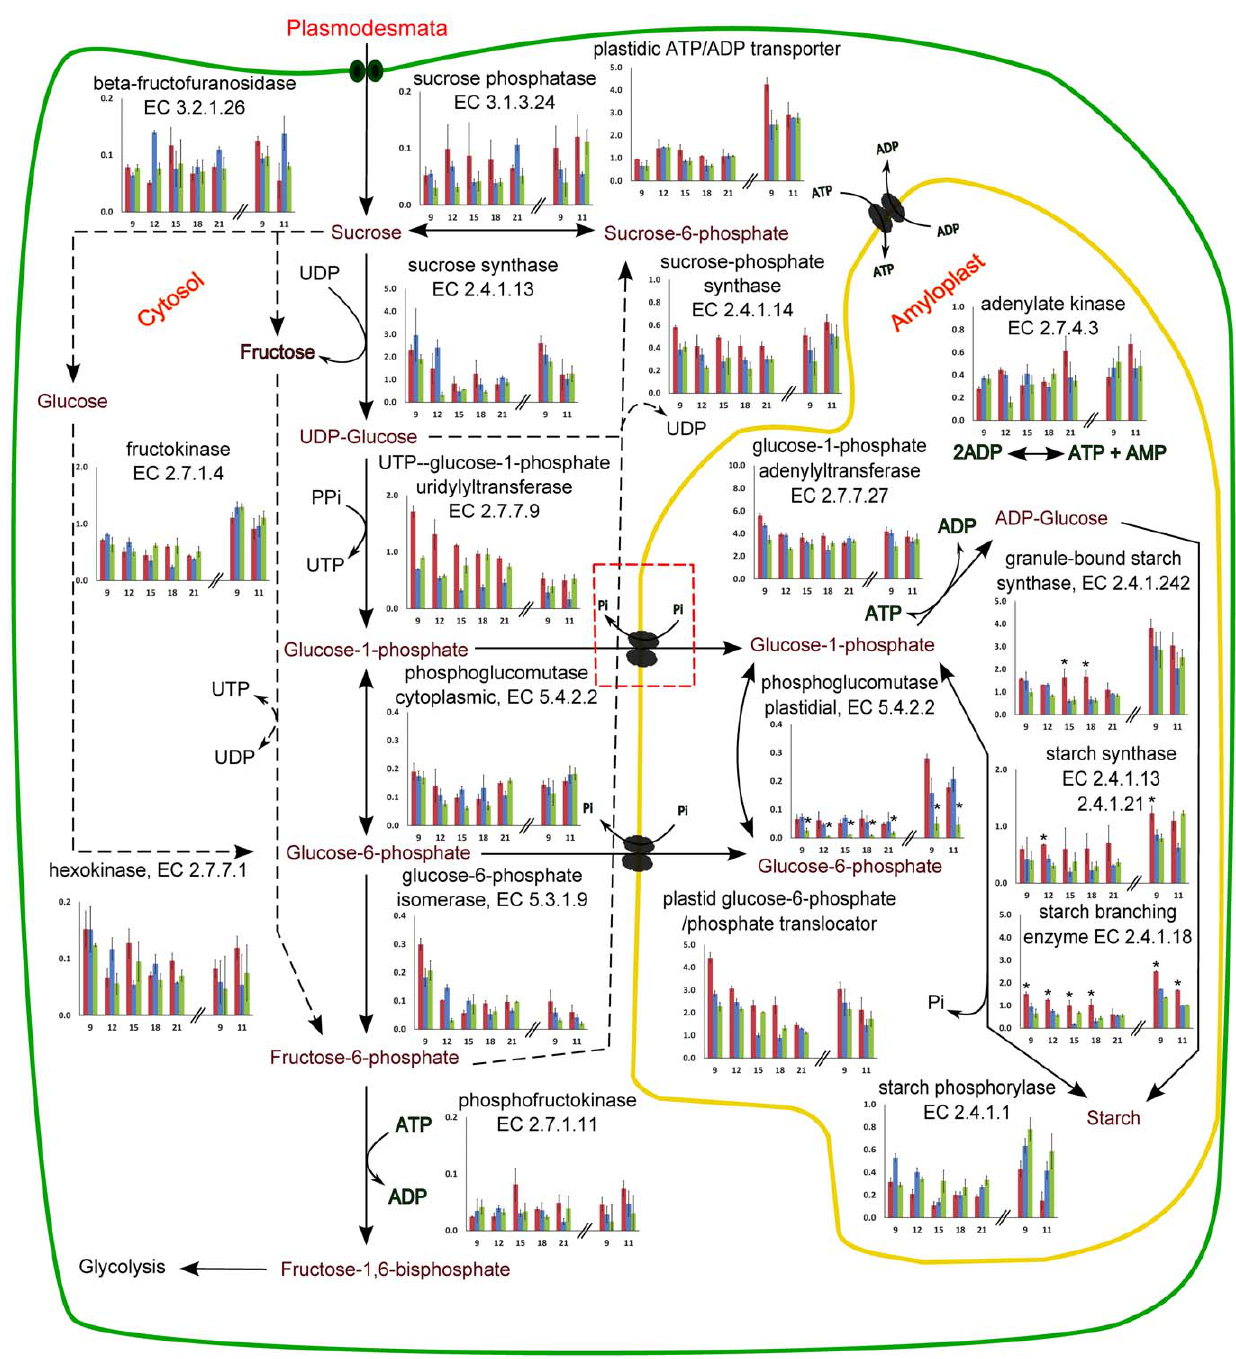
Figure 1. Potato tuber gene expression in starch metabolism throughout tuber bulking. SAGE tags were mapped to genes encoding enzymes involved in starch metabolism. Tag counts per million (y-axis) for multiple enzyme isoforms catalyzing a single step were summed. Desiree is shown in red, Jutlandia in blue and Kuras in green. The error bars indicate standard error of measurement. Numbers on x-axis indicate weeks after planting. Left side of the hatched bars: 2008; right side: 2009. The asterisk symbol indicates gene expression values significantly different than the gene expression of the two remaining cultivars (p-value , 0.05). The solid reaction arrows indicate the major metabolic route of high carbon flux leading to starch accumulation. The hatched lines indicate minor metabolic routes where carbon flux is limited. The red hatched box indicates the G1P transporter suggested by Fettke and coworkers and discussed in this study. The green solid line indicate cell membrane, the yellow line indicates the amyloplastic membrane.